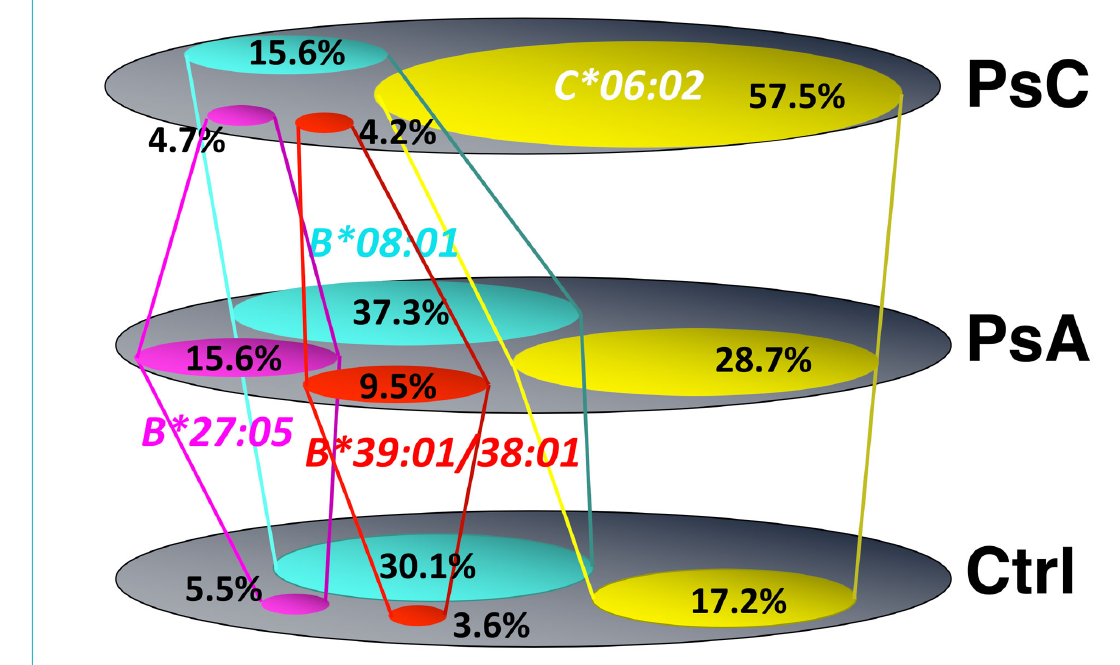
Figure 4: A comparison of the frequencies of the principal HLA-B and HLA-C loci alleles positively associated with susceptibility to psoriatic arthritis depicted as Venn diagrams, emphasizing the difference between allele frequencies in healthy controls and psoriasis. It shows the pso- riasis phenotype is not genetically homogeneous and that psoriatic arthritis (PsA) itself is genetically heterogeneous, with only a smaller sub- set genetically closely related to those with cutaneous psoriasis